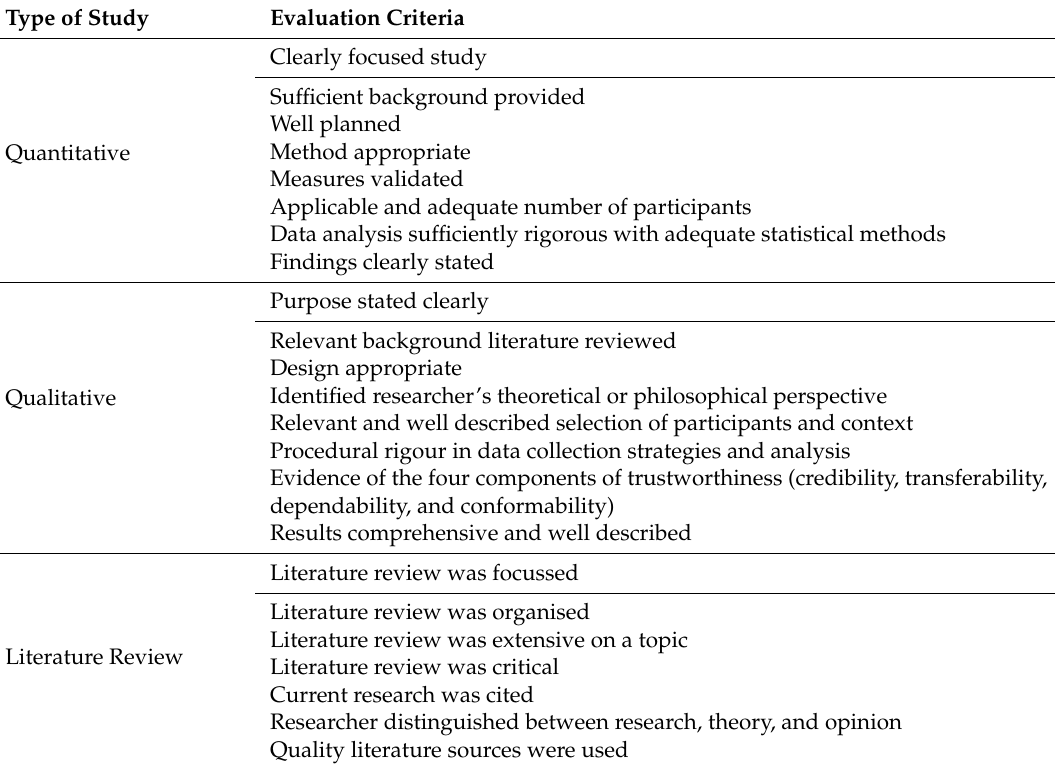
Table 1. Summary of evaluation